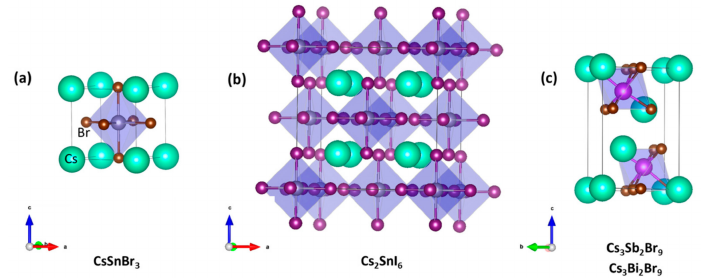
Figure 6. Unit cells of several types of lead-free halide perovskites: ( a ) CsSnBr 3 (inorganic crystal